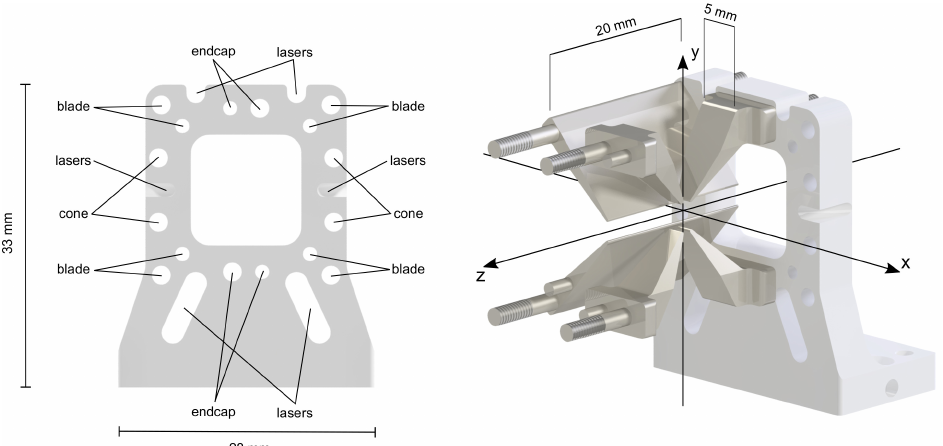
Figure 4. On the left, the front view of the ceramic lateral support. Each hole is used to hold a specific electrode. Extrusions for optical access are indicated with the label “lasers”. On the right, a CAD assembly of some of the electrodes (two RF blades and four endcap electrodes) inserted in the lateral support. The distance between the endcaps’ tips is 3mm along the y axis and 1mm along the z